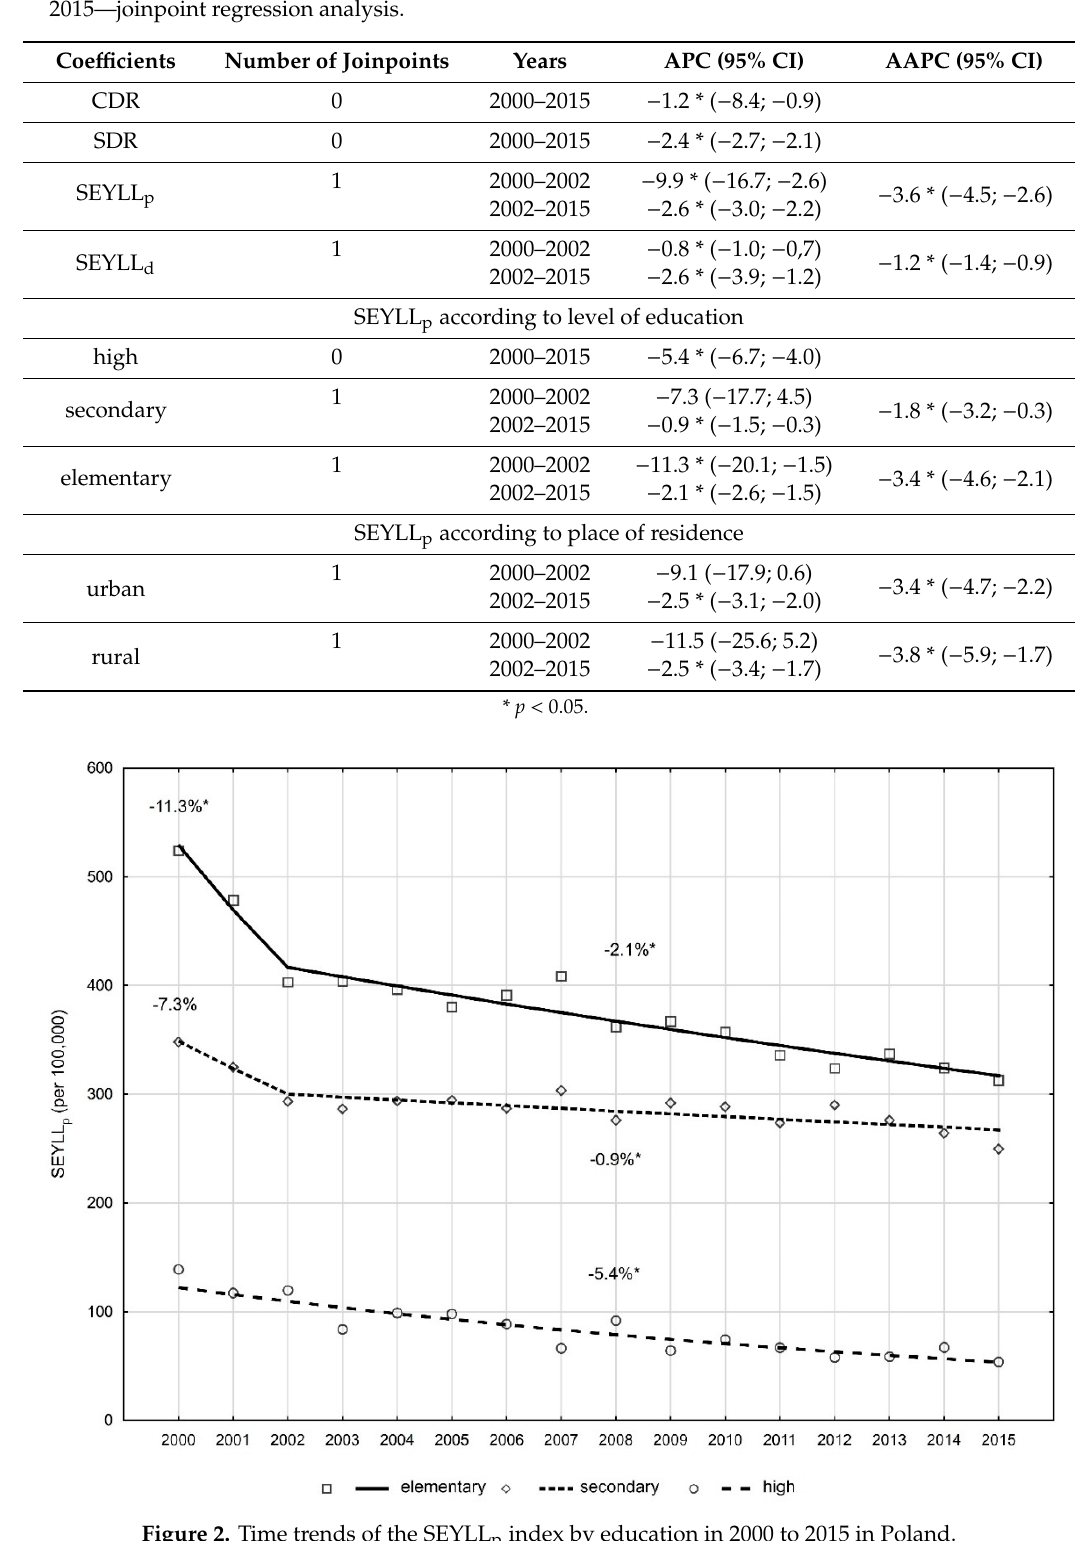
Figure 2. Time trends of the SEYLL p index by education in 2000 to 2015 in Poland.